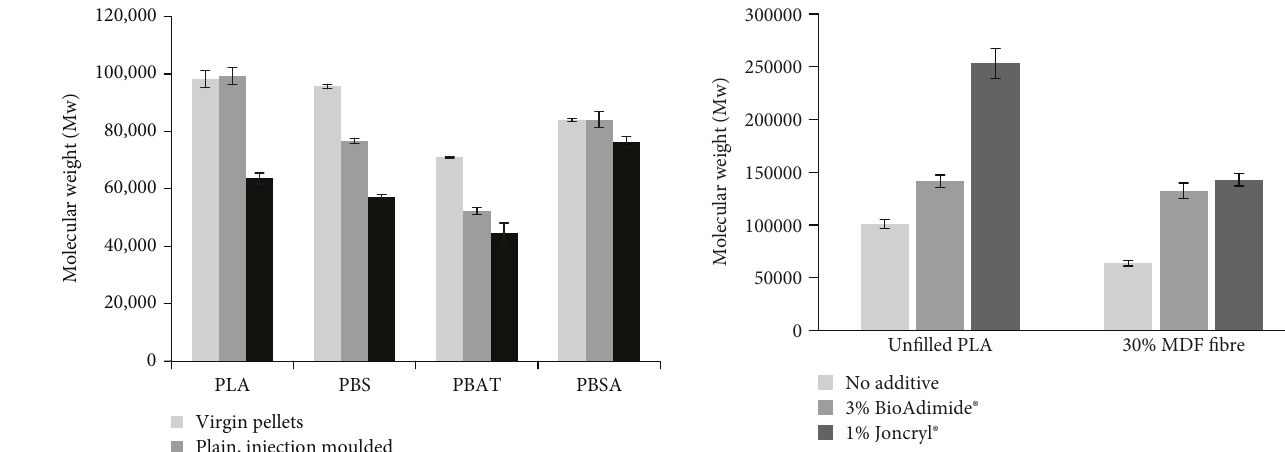
Figure 6: In fl uence of chain extenders on PLA molecular weight (error bars= ± 95% con fi dence interval) ( n = 2 ).